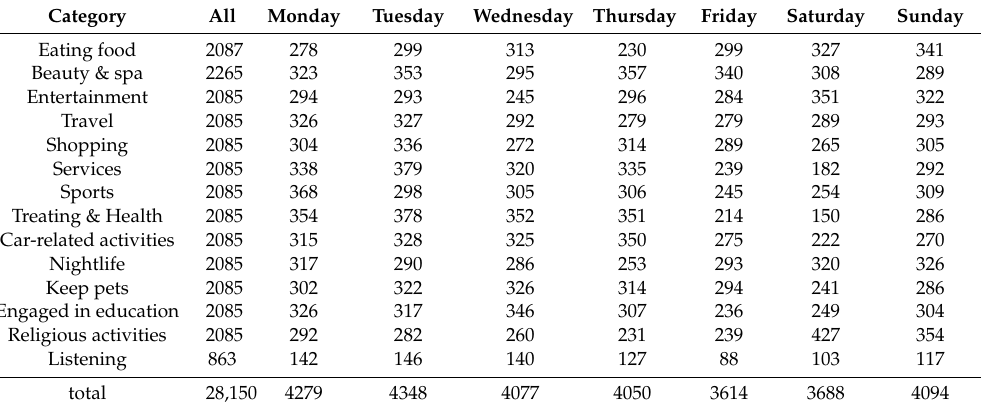
Table 3. Activity categories and their distribution in time.